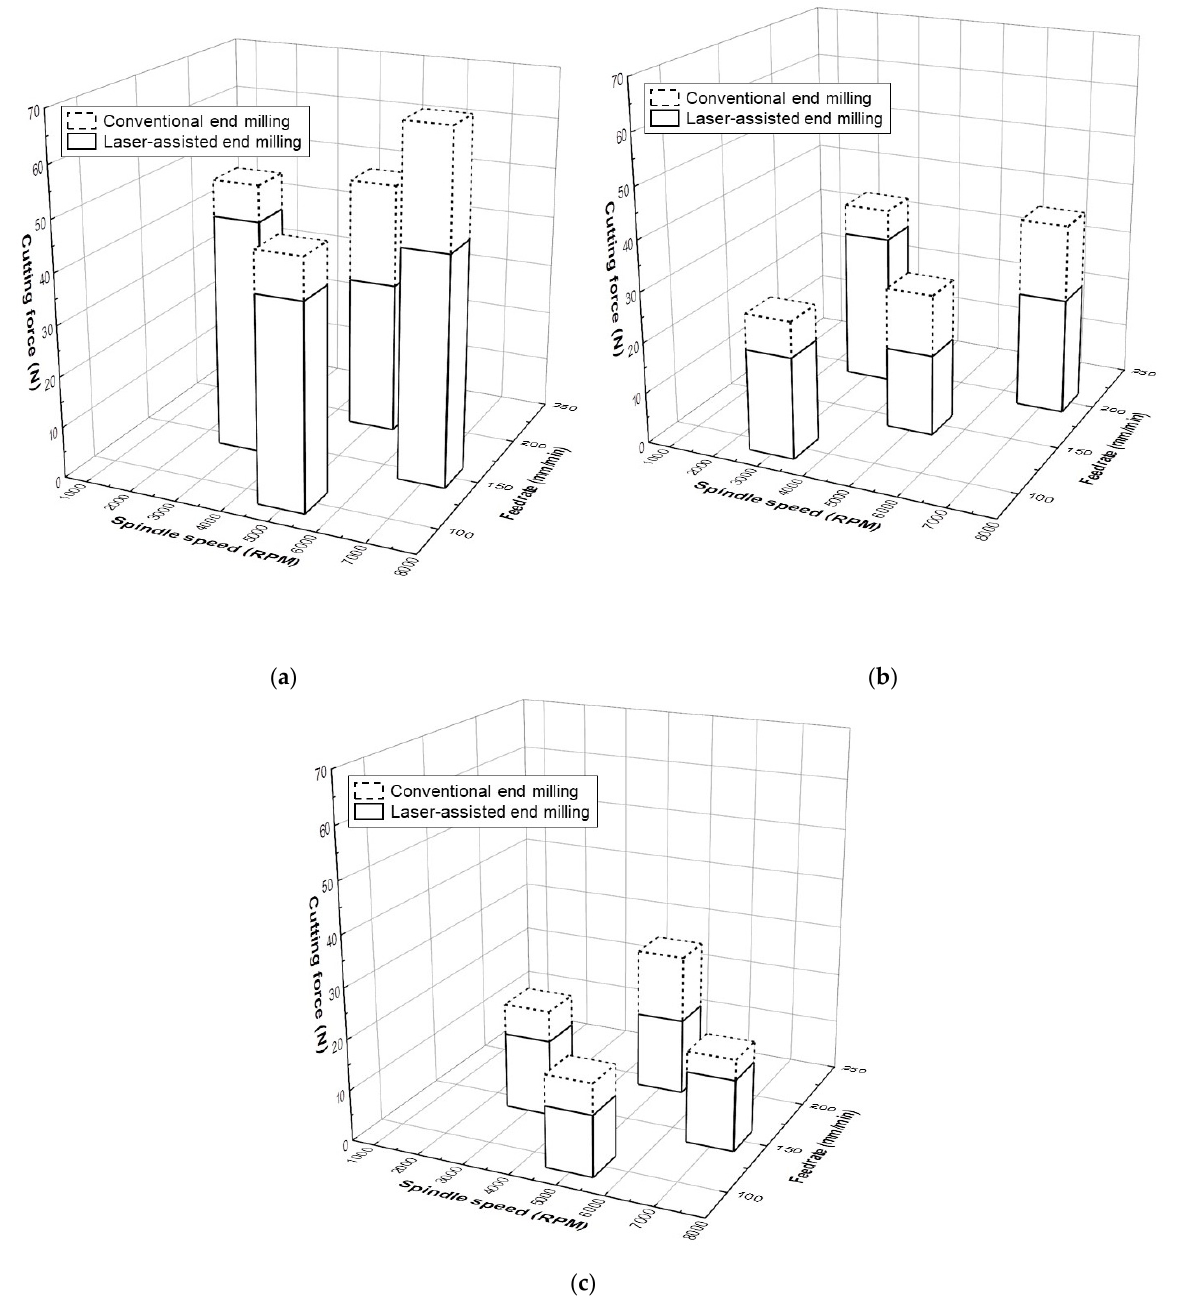
Figure 13. Effect of spindle speed (3000, 5000, 7000 RPM) and federate (100, 150, 200 mm/min) parameters on cutting forces: ( a ) at depth of cut of 0.7 mm; ( b ) at depth of cut of 0.5 mm; ( c ) at depth of cut of 0.3 mm.